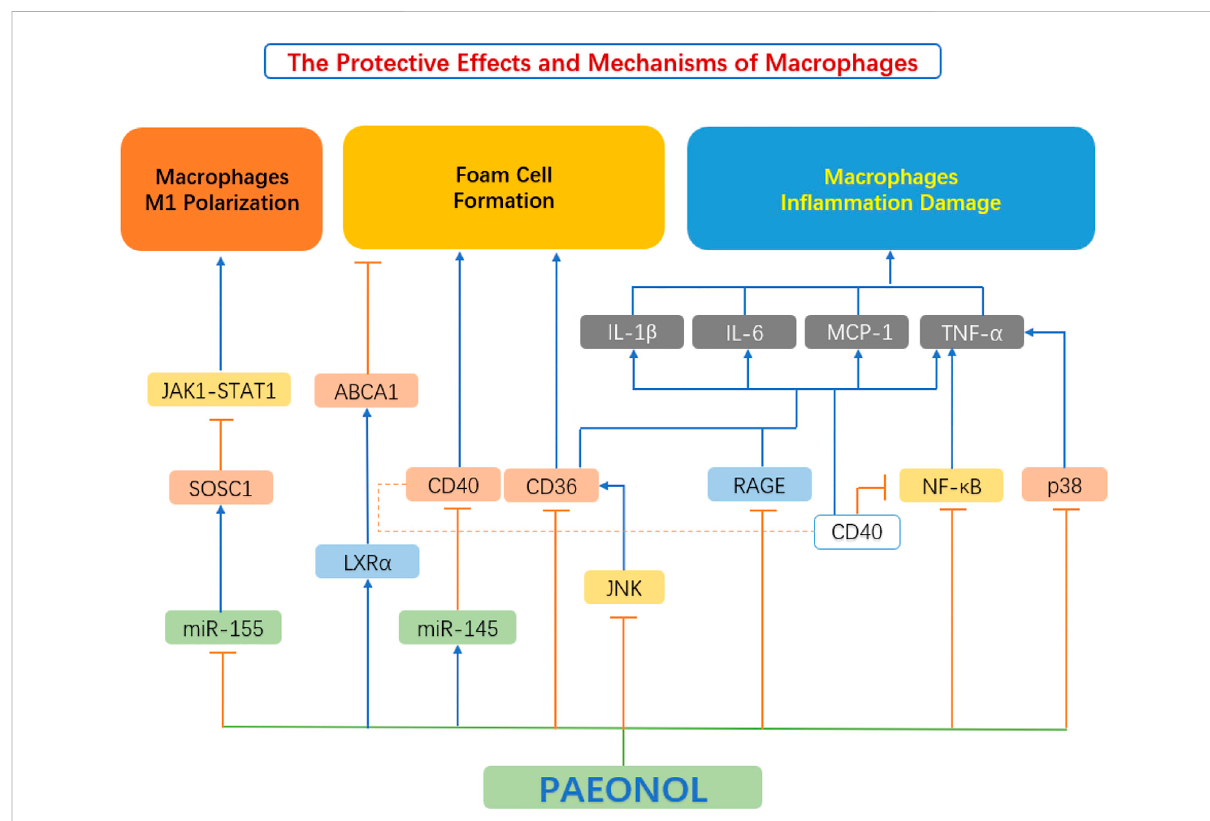
FIGURE 6 The protective effects and mechanisms of paeonol on macrophage functions. ABCA1, ATP binding cassette transporter A1; CD36, scavenger receptors;CD40, cluster of differentiation 40;IL-1 β , interleukin 1 β ;IL-6, interleukin 6; JAK1-STAT1, Janus kinase 1-signal transducer and activator of transcription1;JNK,c-JunN-terminalkinase;LXR α ,liverXreceptor α ;MCP-1,monocytechemoattractantprotein-1;miR-145,microRNA-145;miR- 155,microRNA-155;NF- κ B, thenuclearfactorkB; P38, p38mitogen-activated proteinkinase(MAPK); RAGE,advanced glycation endproducts; SOCS1, suppressor of cytokine signaling 1; TNF- α , tumour necrosis factor α